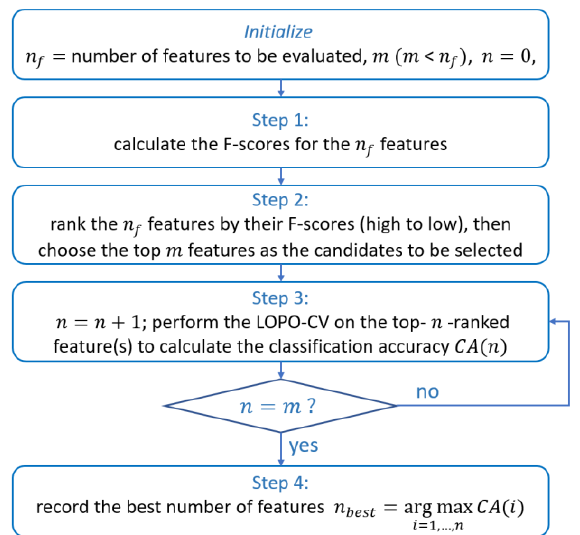
Figure 3. Feature selection based on Fisher’s criterion and top- n -F-score-ranked feature selection strategy.